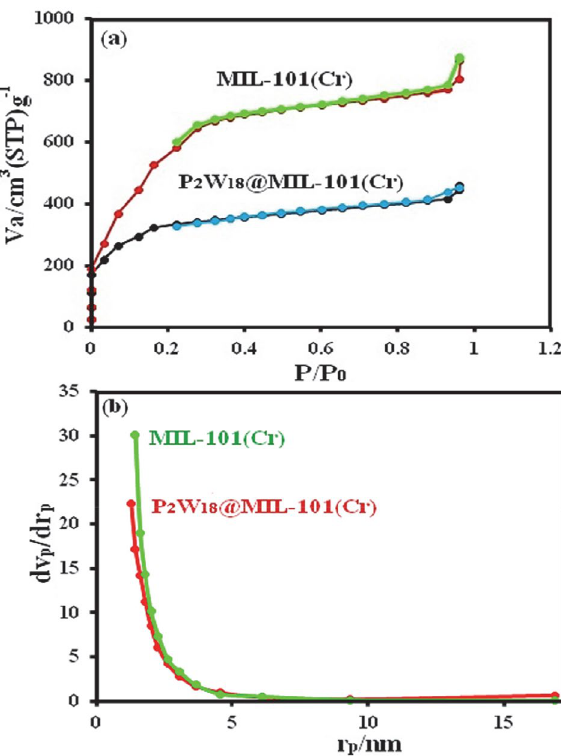
Figure 6. (a) Nitrogen adsorption-desorption isotherms curve at 77 K and (b) pore size distributions obtained by the BJH method for nanohybrid.